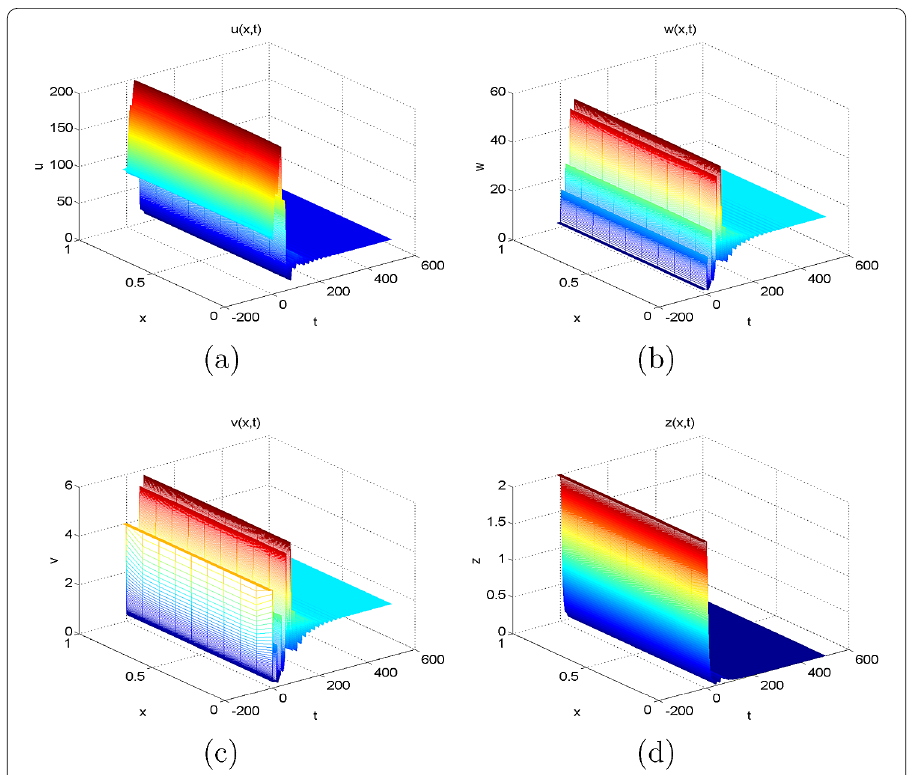
Figure 2 Taking β = 0.2, c = 0.01, q = 0.2, τ 1 = 5, τ 2 = 15, we have R 0 = 3.9696 > 1, R 1 = 0.9227 < 1 , the immune-free equilibrium E 1 (30.5250,18.4547,2.1179,0) is globally asymptotically stable.